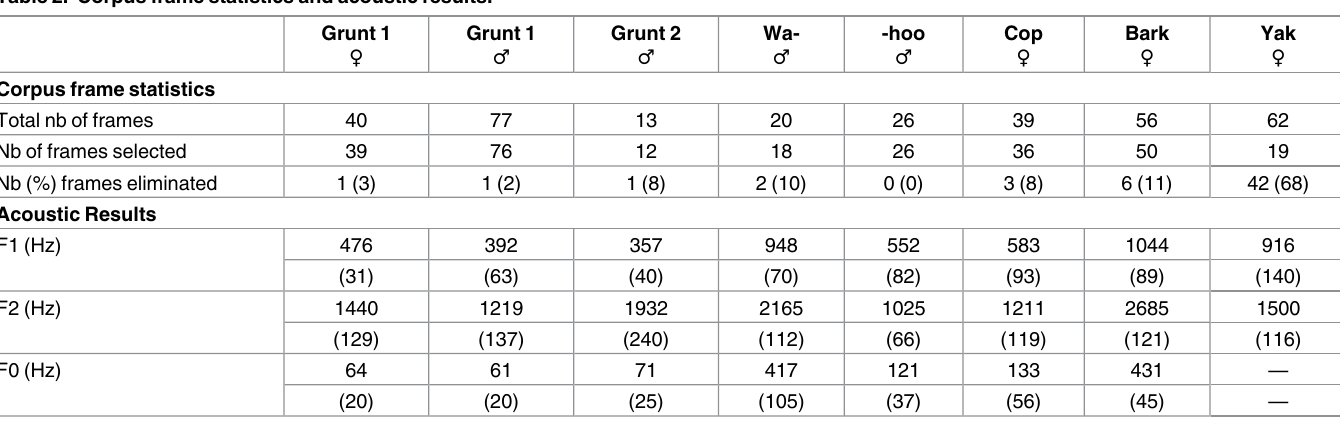
Total number of frames; number of frames selected, number and percentage of frames eliminated, mean and standard deviation (for selected frames) for the first two formants and for the fundamental frequency (after